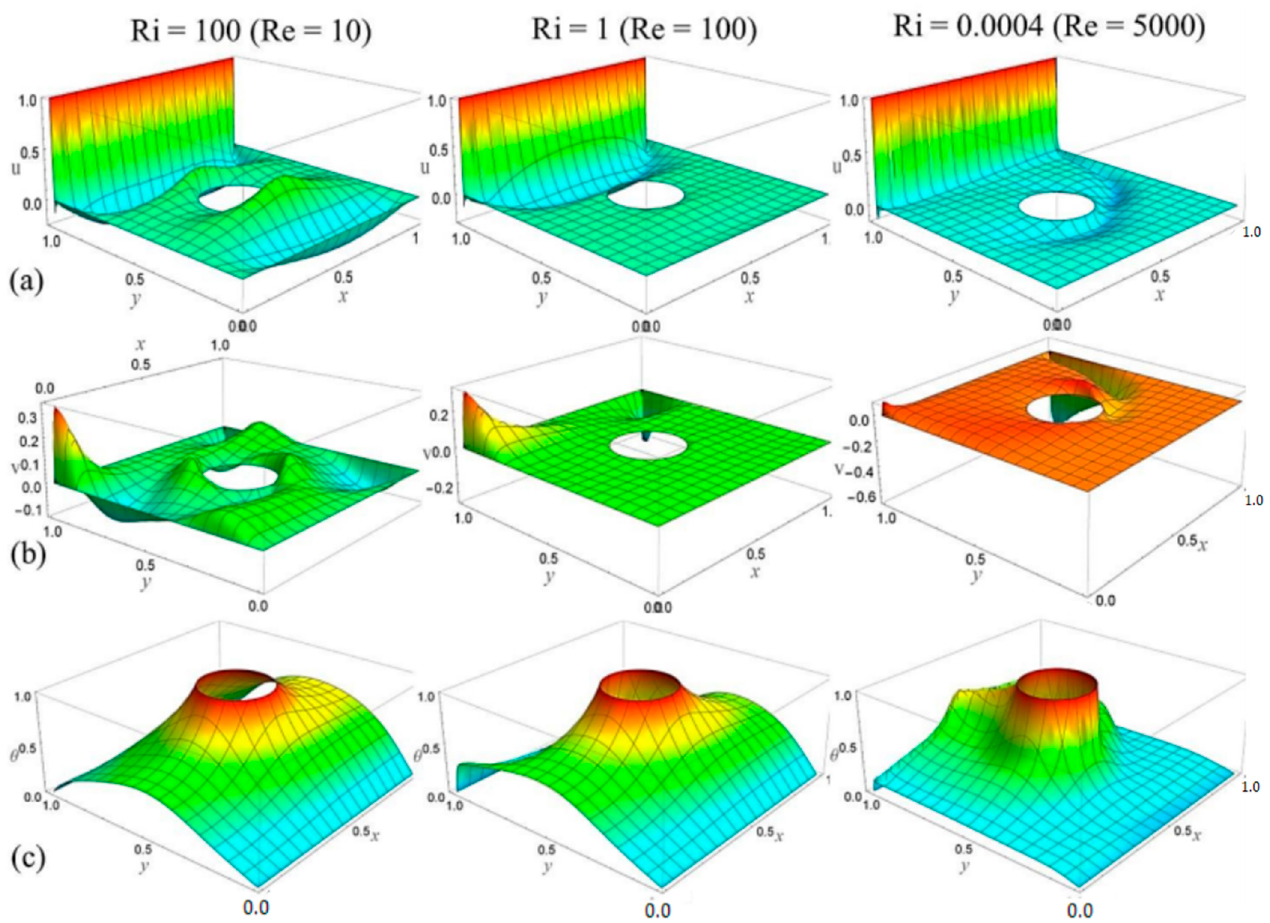
Figure 7. ( a ) u -velocity, ( b ) v -velocity, and ( c ) temperature profile at different Reynolds number, while the other parameters ϕ hnf = 0.02, Ha = 50, Gr = 10 4 , α = 45°, and β = 0° are kept fixed.